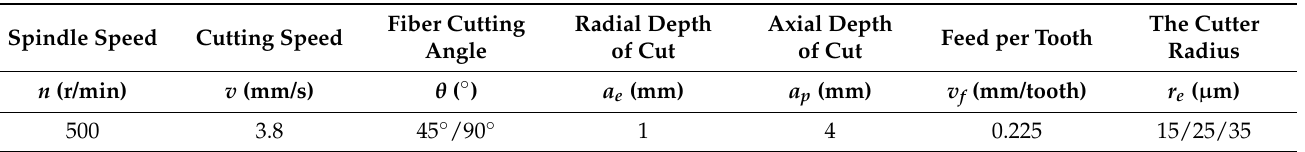
Table 5. The machining parameters used for the tests are shown. The cutting angles were 45 ◦ and 90 ◦ . The edge radii of the tools were 15, 25, and 35 µ